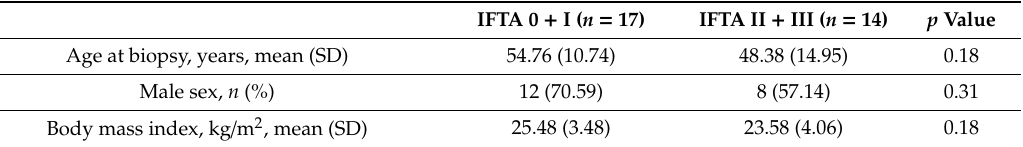
Table 1. Characteristics of the study